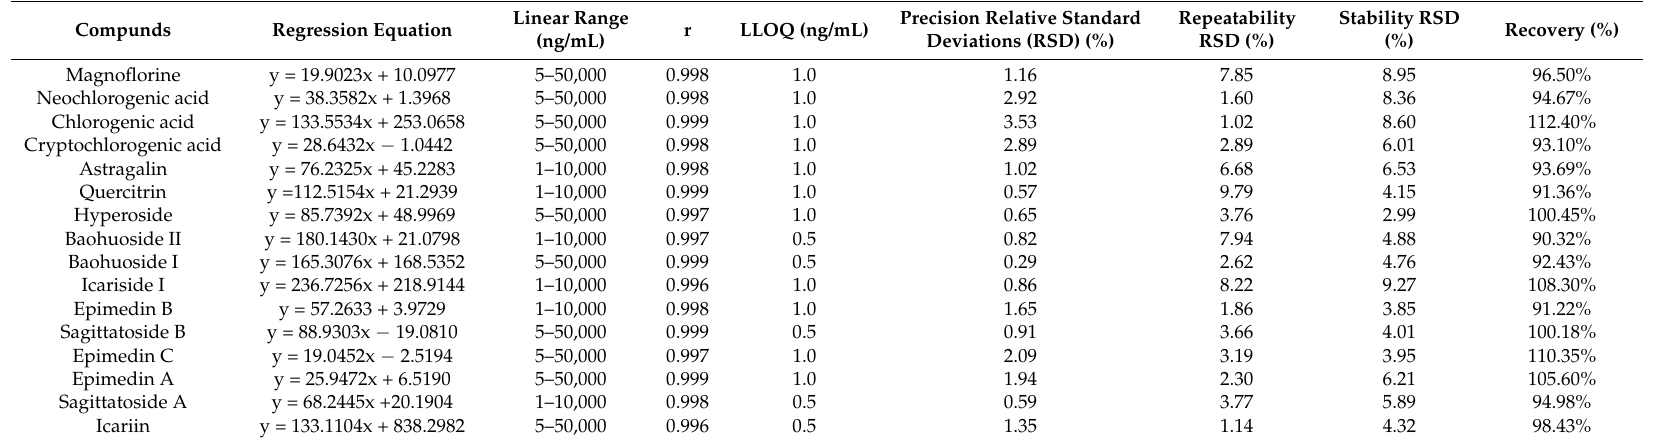
Table 3. Regression equation, linear range, correlation coefficients (r), lower limit of quantitation (LLOQ), precision, repeatability, stability, and recovery of 16 investigated analytes ( n =